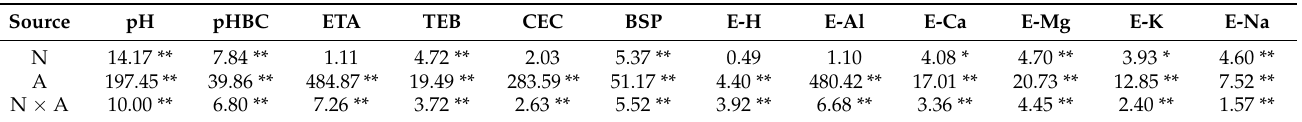
Table 7. F values of inter-subject effect test of N application rate (N) and acidification degree of soil (A) on soil acidification